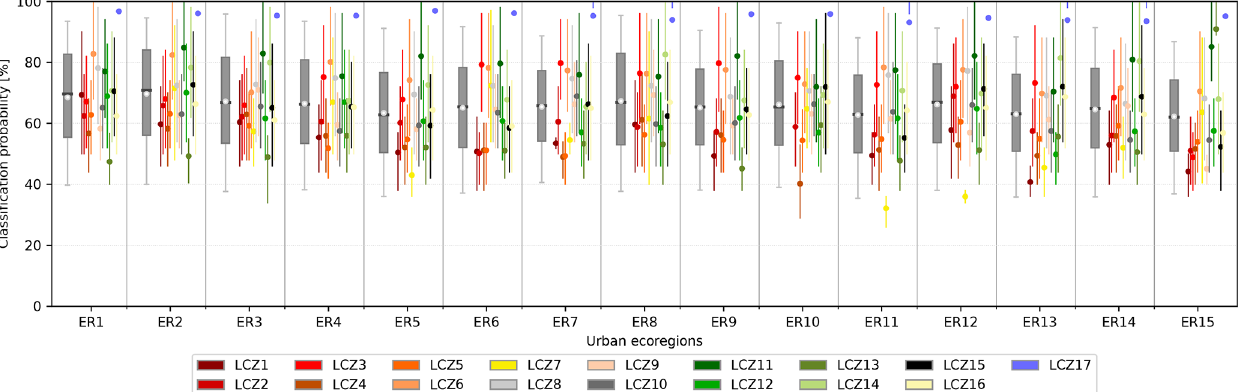
Figure H1. Classification probabilities of the mapped LCZ classes, aggregated over all urban centres from GHS-UCDB. The grey boxplots depict the classification probability distribution for all global urban centres, per ER, with boxes and whiskers spanning the 25th–75th and 5th–95th percentiles respectively and means and medians indicated by the white dots and black lines respectively. The vertical lines in the colours of the LCZ classes indicate the 25th–75th percentile range averaged over the urban centres, with LCZ-coloured dots indicating the